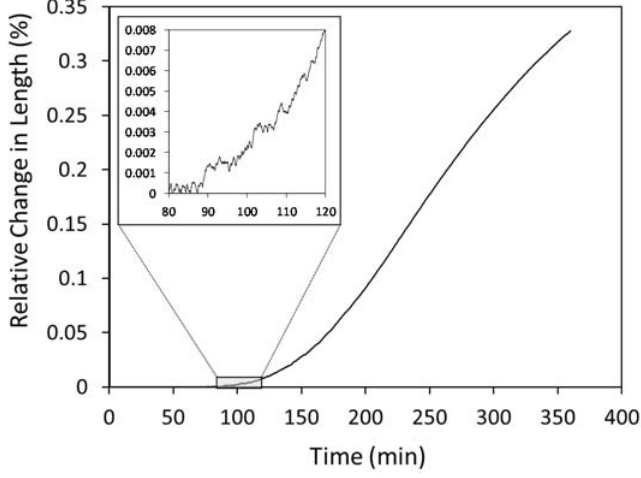
Figure 12. Time dependent evolution of the relative change in length during an austempering treatment at 230 ◦ C for 360 min.